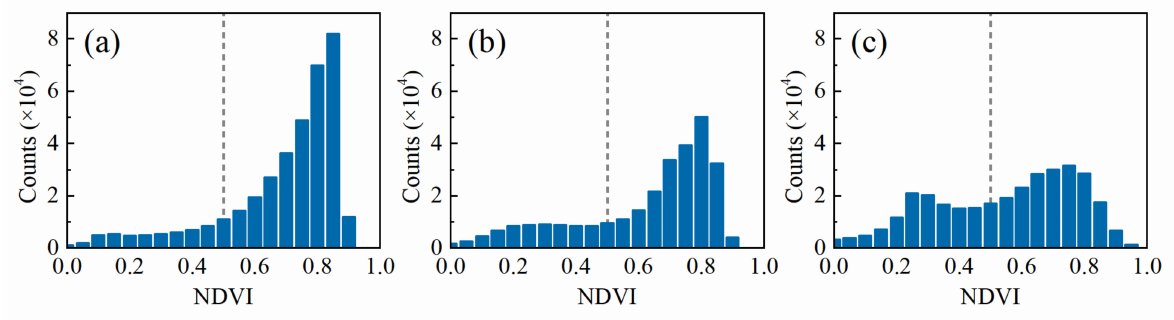
Figure 14. Frequency histograms of maximum NDVI values after 15 September 2019 at the area of classified unrecovered croplands. The dash line indicates a NDVI value of 0.5. ( a – c ) represent the study site in the Chao Lake, the Poyang Lake, and the Huai